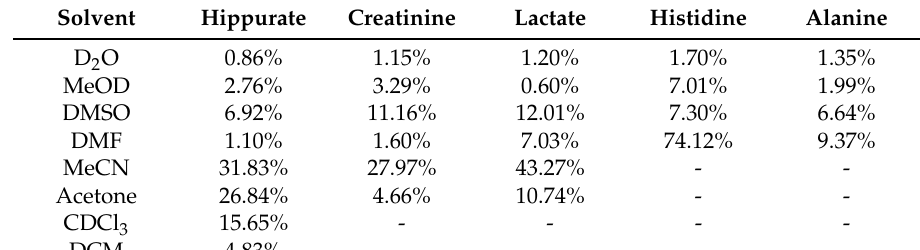
Table 1. Relative standard deviation of selected integral values.